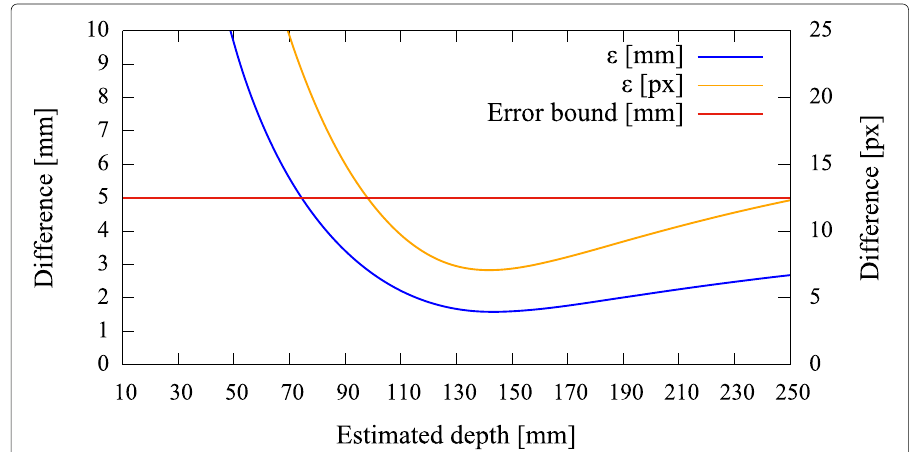
show their minima at ≈ 140 mm